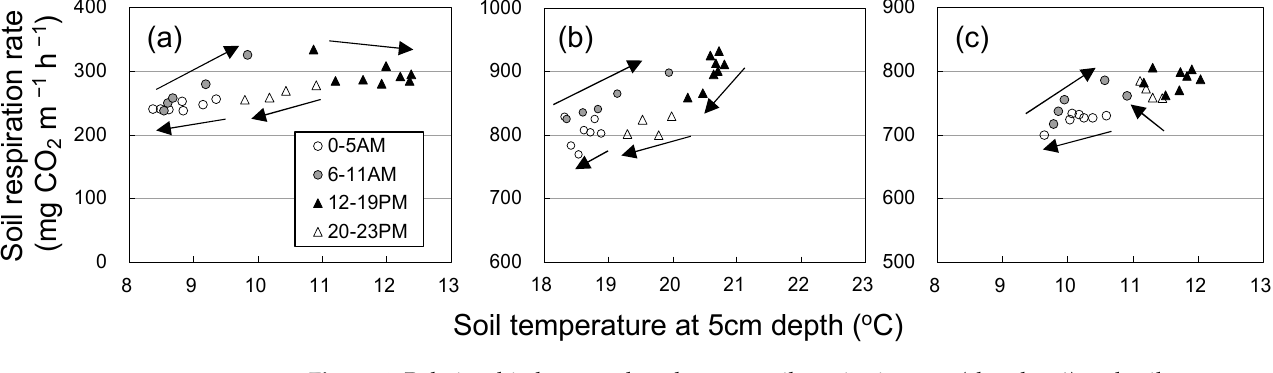
Figure 4. Relationship between hourly mean soil respiration rate (chamber 1) and soil temperature at a depth of 5 cm on sunny days in ( a ) spring (28 April to 3 May), ( b ) summer (14 to 18 July), and ( c ) autumn (5 days from 3 to 22 October).